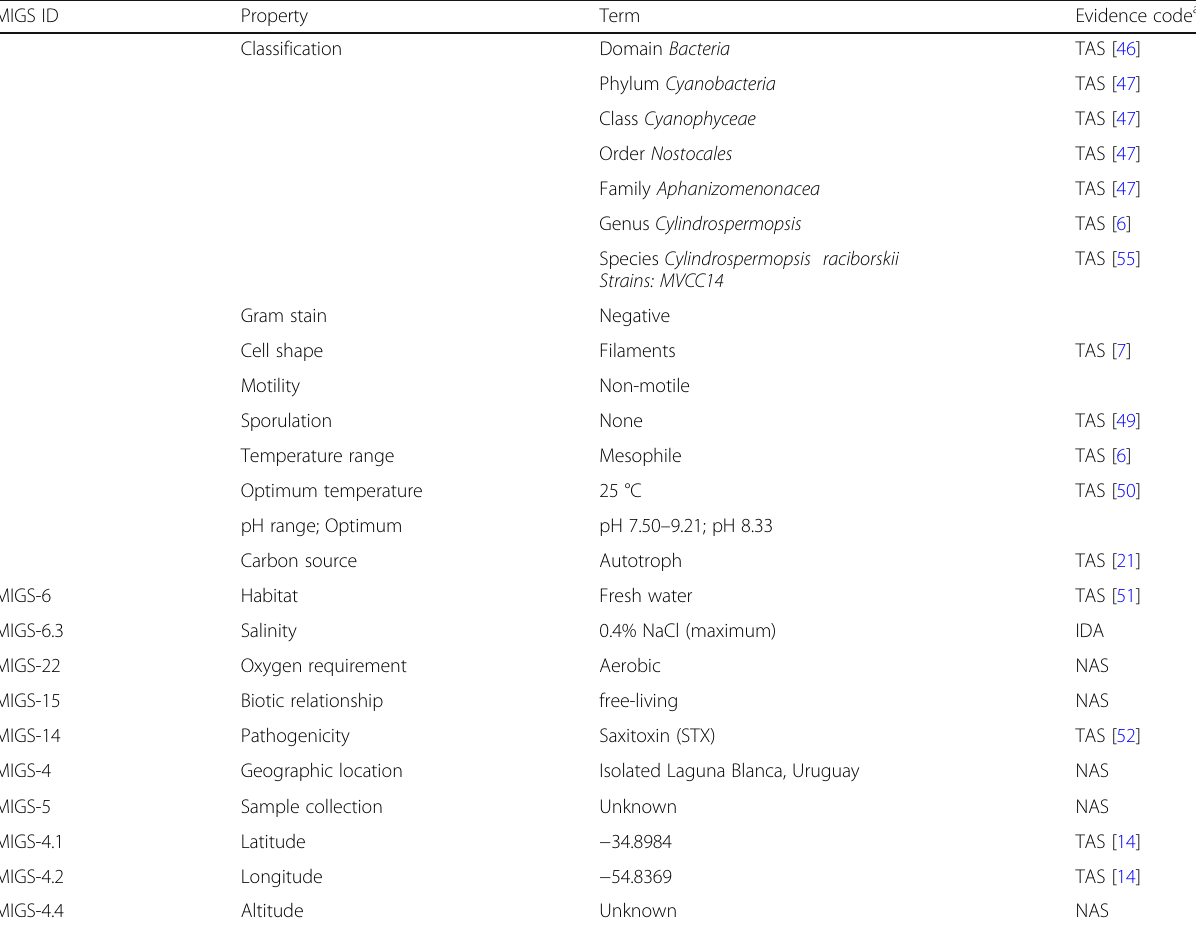
Table 2 Classification and general features of C. raciborskii strain MVCC14 according to MIGS designation